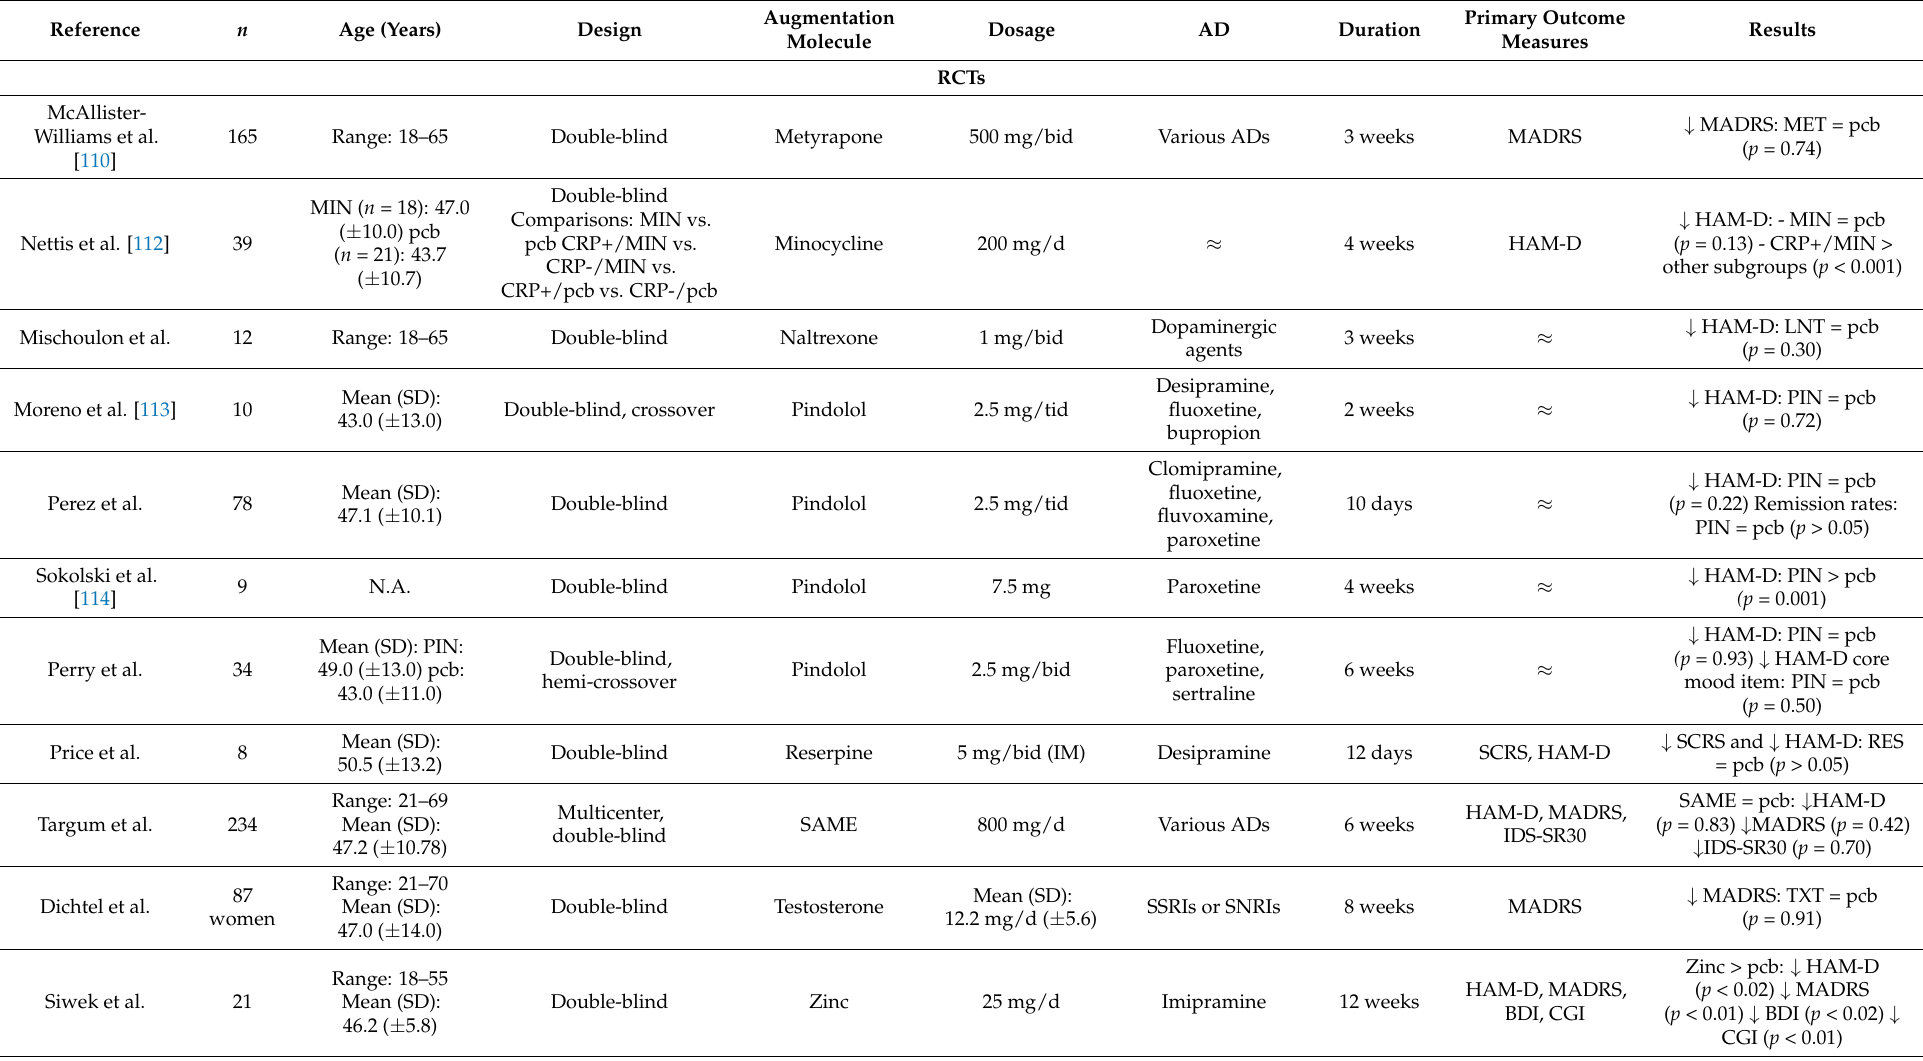
Table 6. Summary of the studies about augmentation with non-psychopharmacological agents, other molecules and supplements in